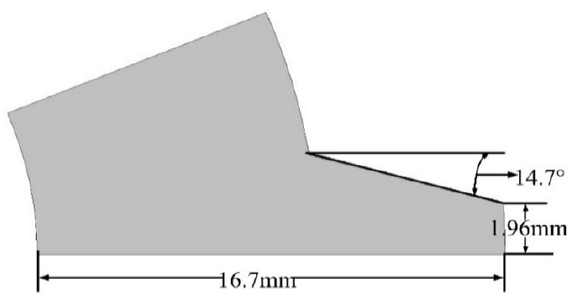
Figure 16. Arcing of the rotor pole.